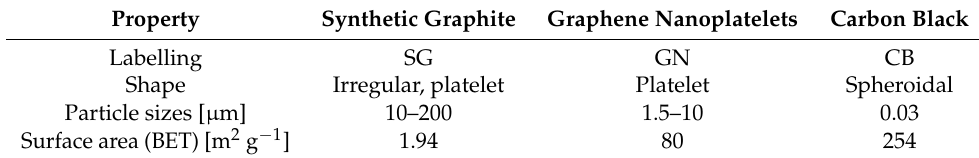
Table 1. Morphological parameters of the carbon fillers used. Property Synthetic Graphite